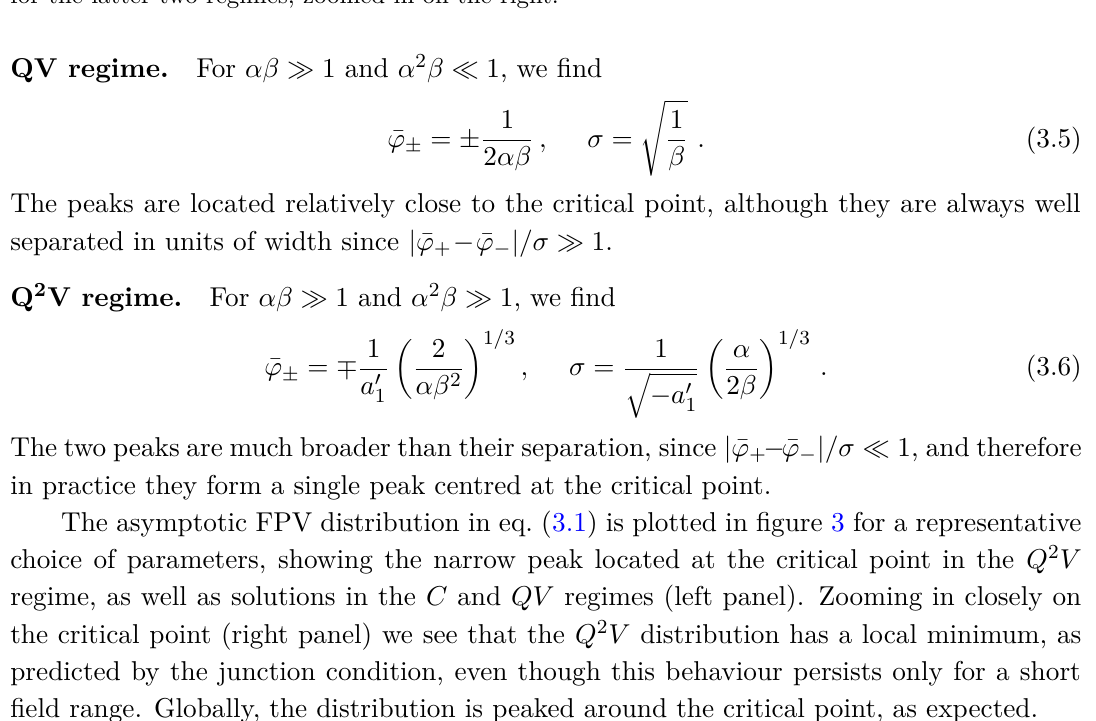
Figure 3 . The asymptotic volume-weighted field distribution for a pyramid potential with absorb- ing boundary conditions at ϕ = ± 1 , for α = 10 − 2 and β = 10 (C regime), 10 3 (QV regime), 2 × 10 4 (Q 2 V regime). The figure shows the occurrence of SOL and of a peak at or near the critical point for the latter two regimes, zoomed in on the